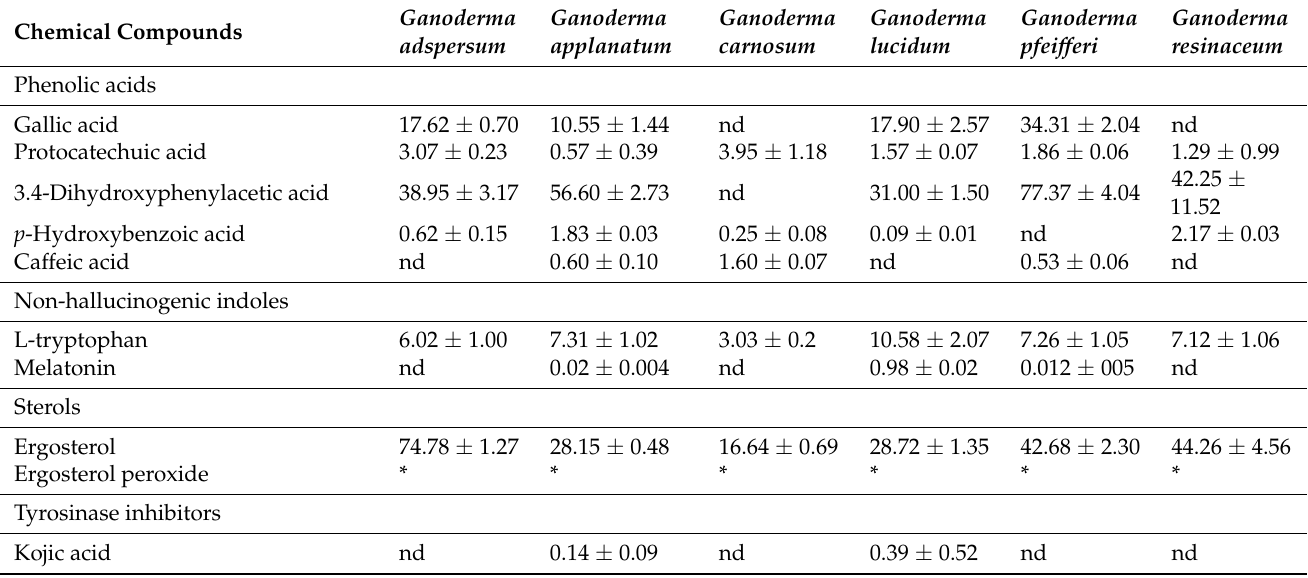
Table 1. Selected chemical compounds in the extract from biomass of Ganoderma spp. (mg/100 g